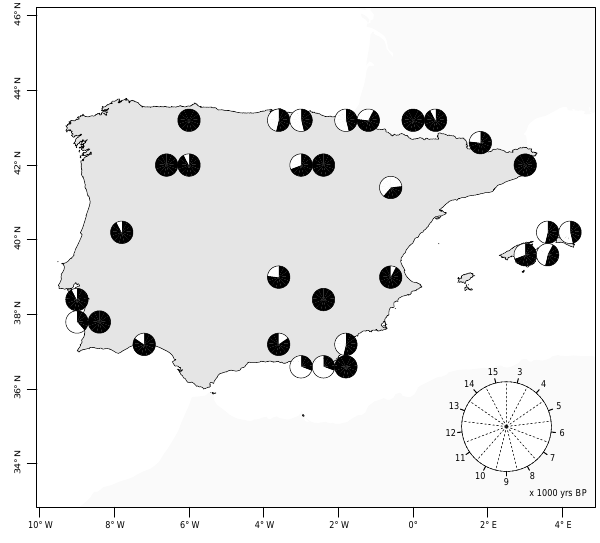
Figure 1. Study area with sample points. The black area inside each circle represents the ages available in each pollen